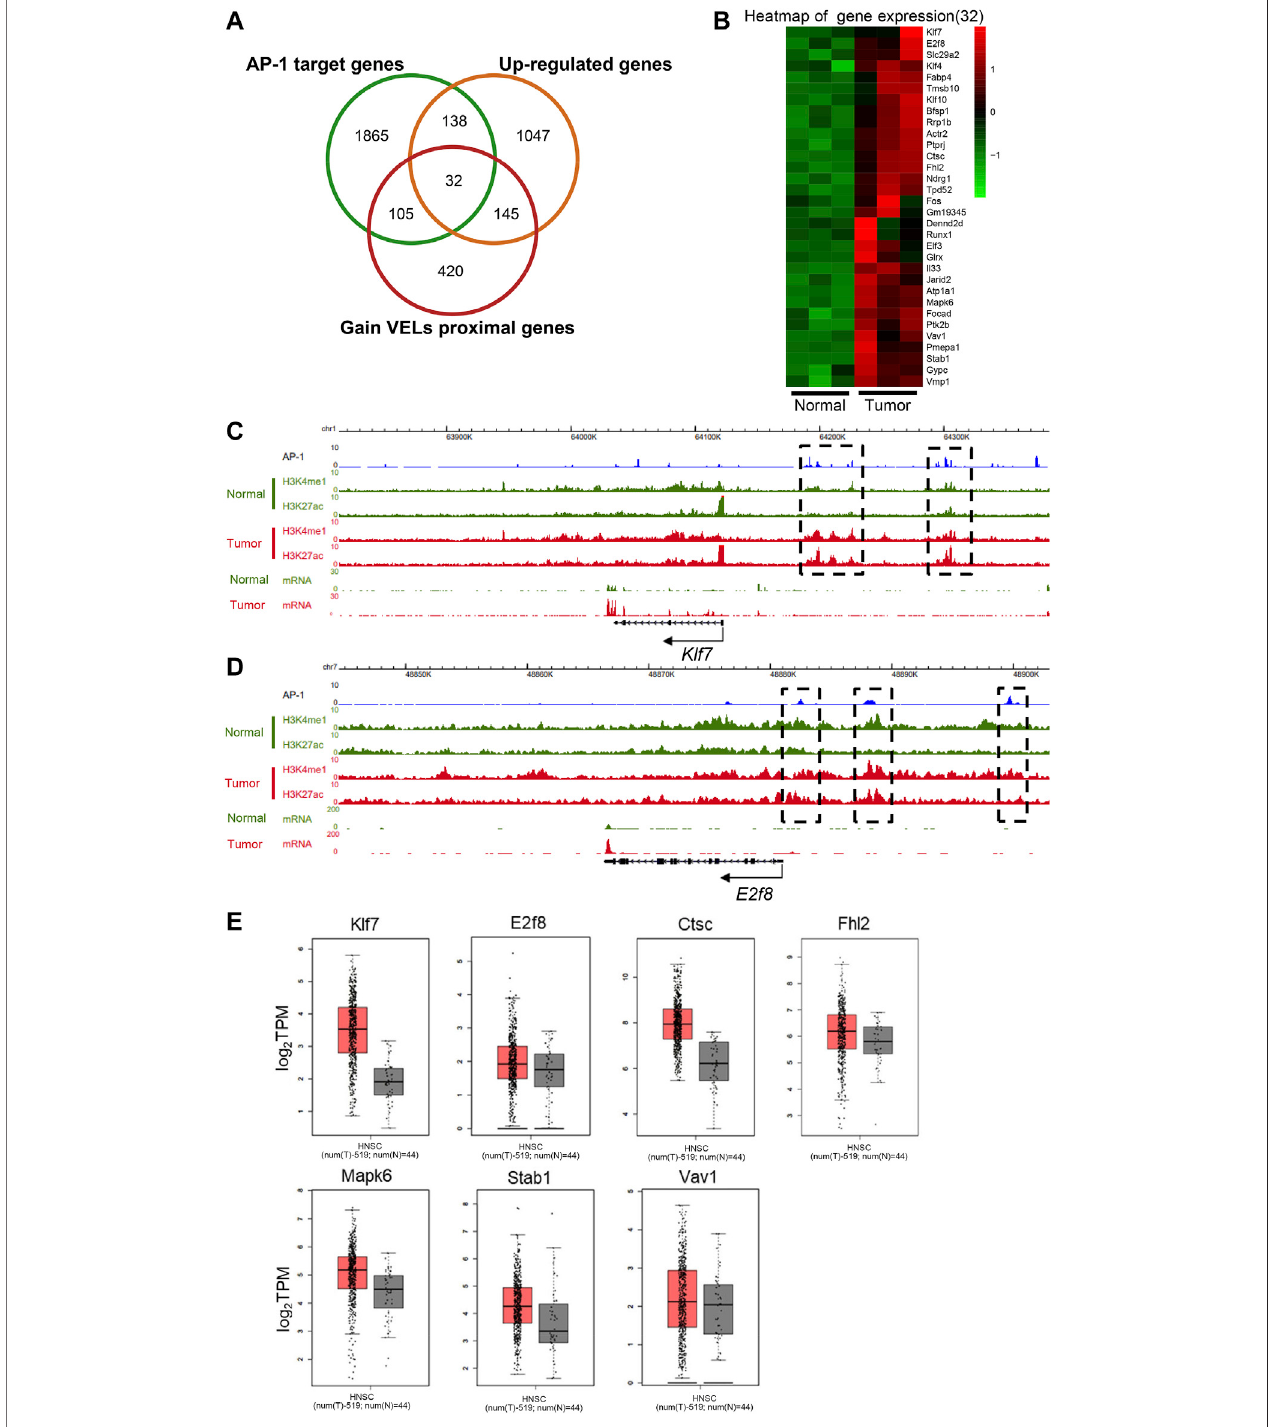
FIGURE 6 | Coordination of AP-1 and enhancer histone modi fi cations on transcription regulation. (A) Venn diagram to show the overlapped genes numbers between AP-1 target genes,upregulated DEGsand gainVEL proximal genes. (B) Heat map toshow the geneexpression ofthe 32overlapped target genes inFigureA. (C and D) The genome browser view showed H3K27ac and H3K4me1 signals, and mRNA expression in normal and tumor tissues of Klf7 (C) and E2f8 (D) genes. The black boxes highlighted the identi fi ed VELs. (E) Box plots to show the expression (log2 TPM) of the identi fi ed overlapped genes of Figure 6B in tumor and normal tissues in TCGA database. Bfsp1 was shown in Figure 5F